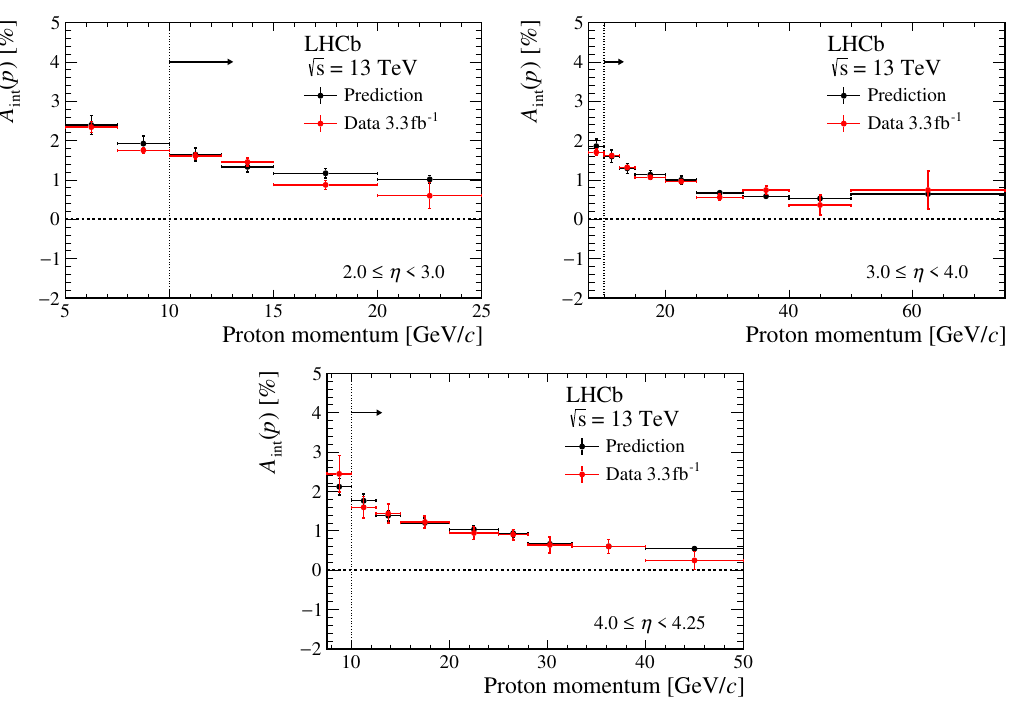
Figure 6 . Proton-interaction asymmetry measured as difference in detection asymmetries between protons originating from (cid:3) p(cid:25) (cid:0) and pions from K 0 (cid:25) + (cid:25) (cid:0) decays in 2017 and 2018 data, S ! ! split in three intervals of pseudorapidity. The (cid:17) ranges are [2 ; 3] , [3 ; 4] and [4 : 00 ; 4 : 25] from top left to bottom. Also shown are the predictions from the proton-deuterium cross-sections. Model uncertainties shown here are a constant 10% uncertainty due to the knowledge on the material budget [28]. These uncertainties are not used in the (cid:31) 2 values reported in the text. The vertical line shows the lower cutoff in momentum used in the